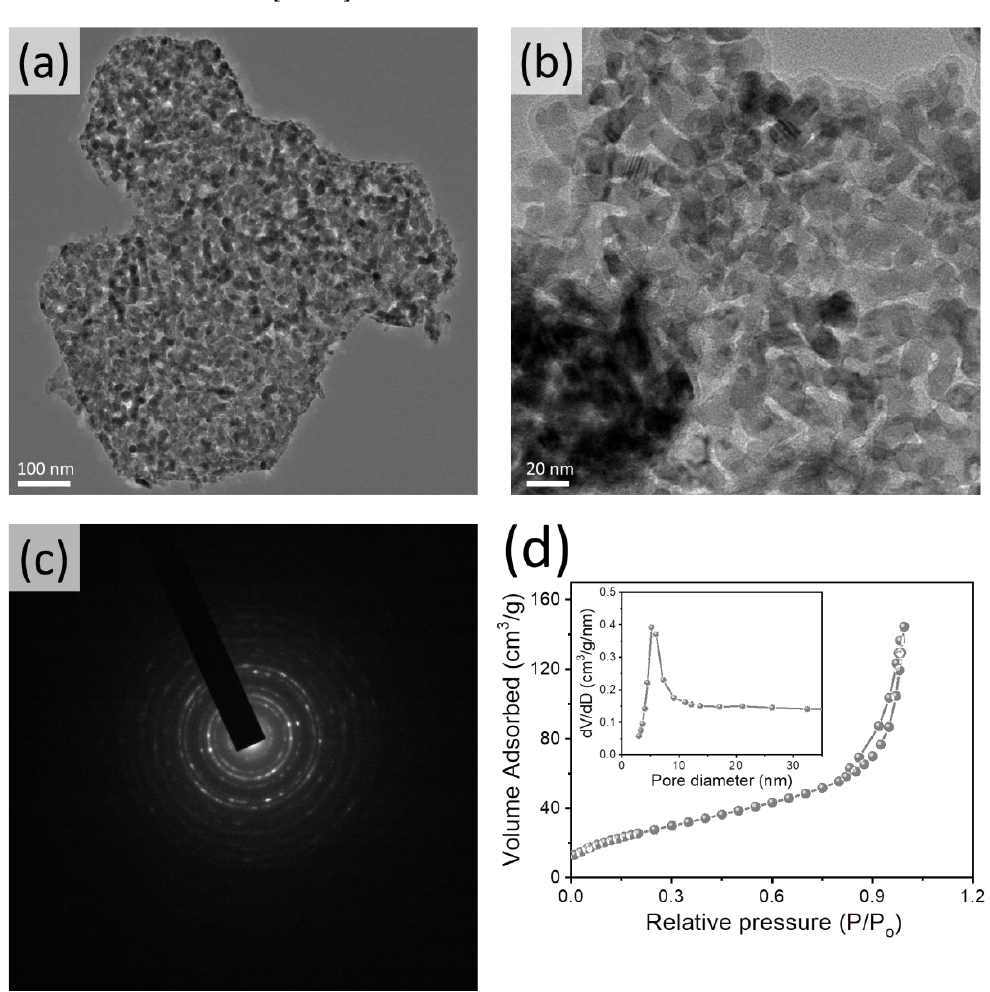
Figure 2. TEM images at low- ( a ), high- ( b ) magnifications, SAED pattern ( c ), and BET Nitrogen adsorption-desorption isotherms of porous cobalt oxide sheet-like nanostructure. Inset ( d ) shows the pore size distribution plot of cobalt oxide sheet-like nanostructure.